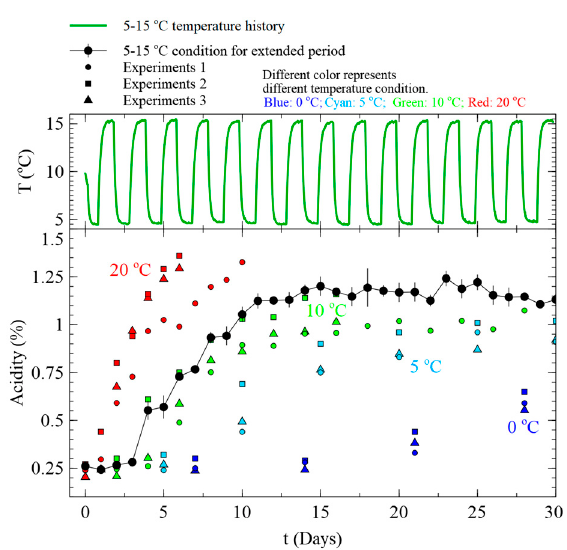
Figure 7. Variation of N max under fluctuating temperature conditions. The black circles represent the measured acidity variation under fluctuating temperature conditions. The green line shows the fluctuating temperature history tested. The black circles with connecting lines and error bars represent the observed acidity variation with time and the measured standard deviation at each point. The different symbols, i.e., circles, squares, and triangles, are used to represent data from different batch of experiments. The different colors categorize different constant temperature conditions.